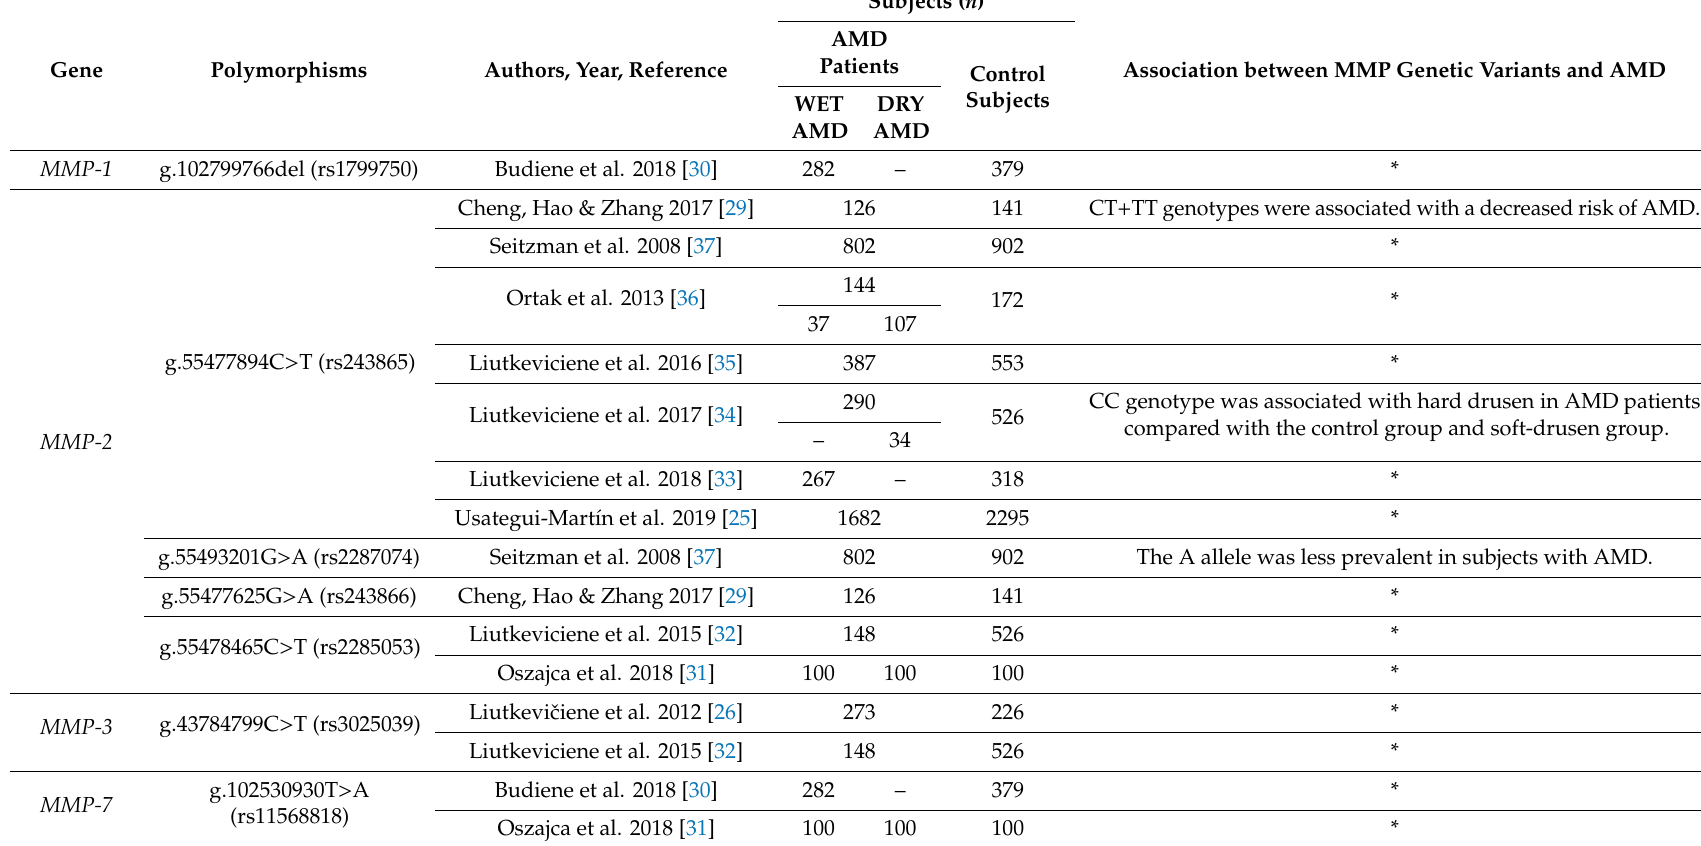
Table 1. MMPs polymorphisms associated with